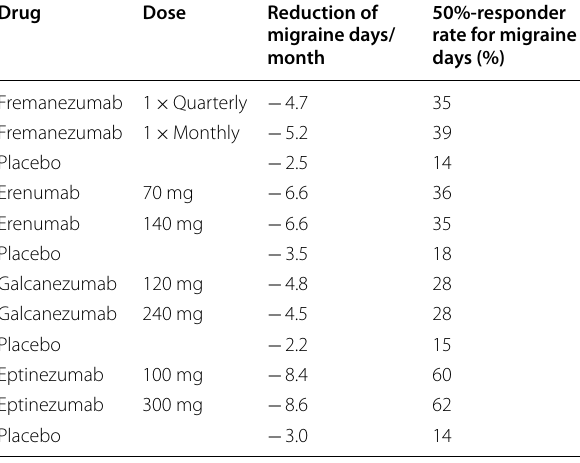
Table 2 Efficacy of monoclonal antibodies against CGRP or the CGRP receptor in the therapy of MOH Drug Dose Reduction of migraine